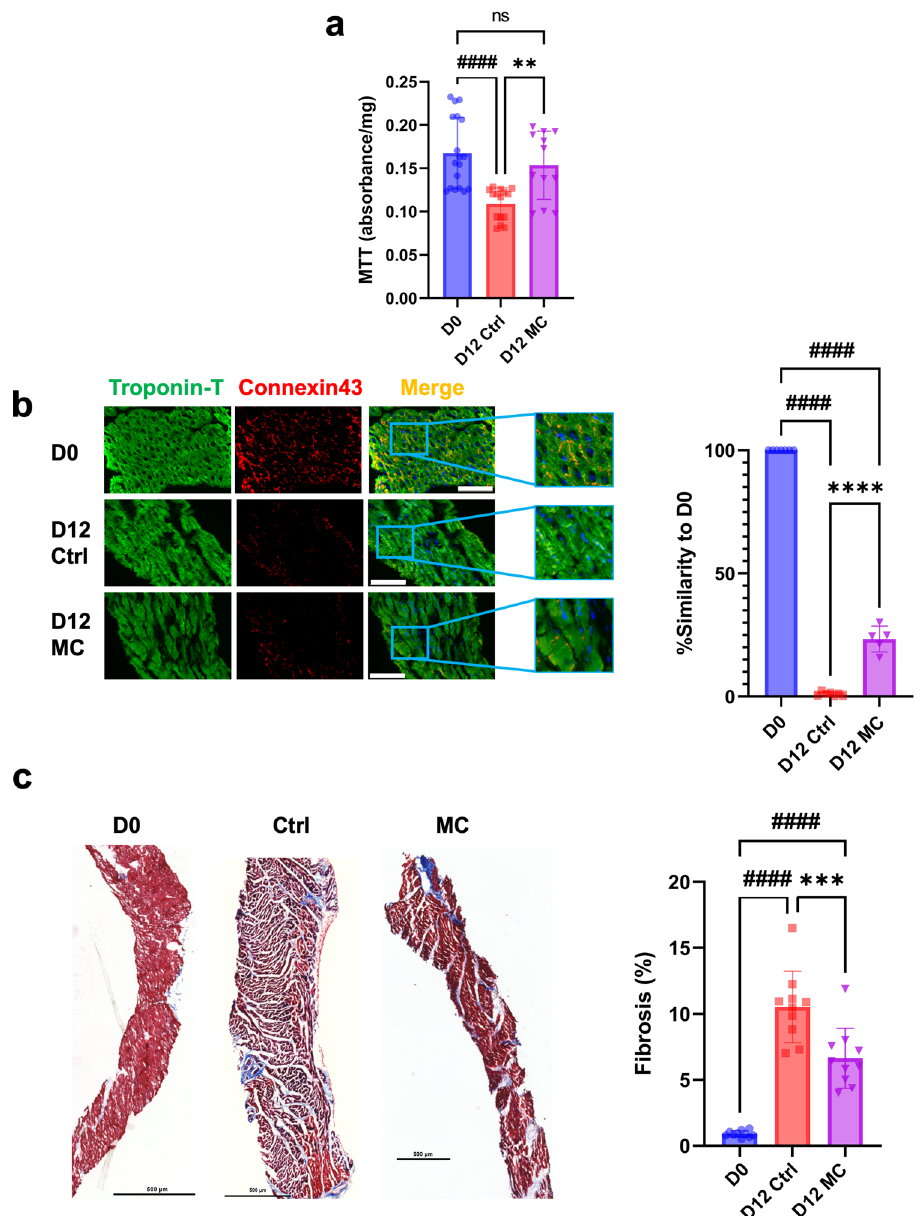
Fig. 3 Mechanical stimulation partially improves tissue slice viability and structural integrity after 12 days in culture. a Bar graph shows quanti fi cation of the MTT viability of fresh heart slices (D0) or heart slices culture for 12 days either in static culture (D12 Ctrl) or in CTCM (D12 MC) ( n = 18 (D0), 15 (D12 Ctrl), 12 (D12 MC) slices/group from different pigs, one way ANOVA test is performed; #### p < 0.0001 compared to D0 and ** p < 0.01 compared to D12 Ctrl). b Representative immuno fl uorescence images for troponin-T (green), connexin 43 (red), and DAPI (blue) for freshly isolated heart slices (D0) or heart slices cultured for 12 days under static conditions (Ctrl) or CTCM conditions (MC) (Scale bare = 100 µ m). Arti fi cial intelligence quanti fi cation of the heart tissue structural integrity ( n = 7 (D0), 7 (D12 Ctrl), 5 (D12 MC) slices/group each from different pig, one-way ANOVA test is performed; #### p < 0.0001 compared to D0 and **** p < 0.0001 compared to D12 Ctrl). c Representative images (left) and quanti fi cation (right) for heart slices stained with Masson ’ s trichrome stain (Scale bare = 500 µ m) ( n = 10 slices/group each from different pig, one-way ANOVA test is performed; #### p < 0.0001 compared to D0 and *** p < 0.001 compared to D12 Ctrl). Error bars are representative of the Mean ±